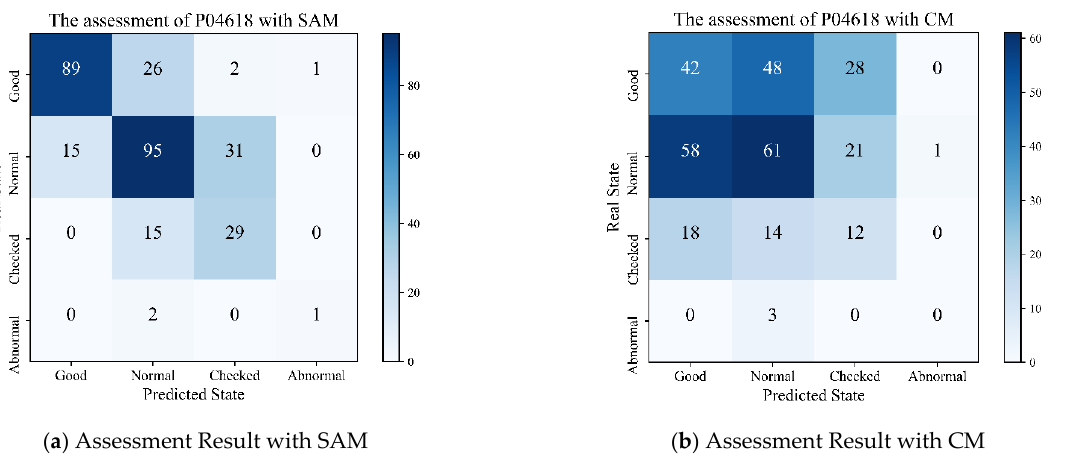
Figure 13. Assessment results of node P04618.